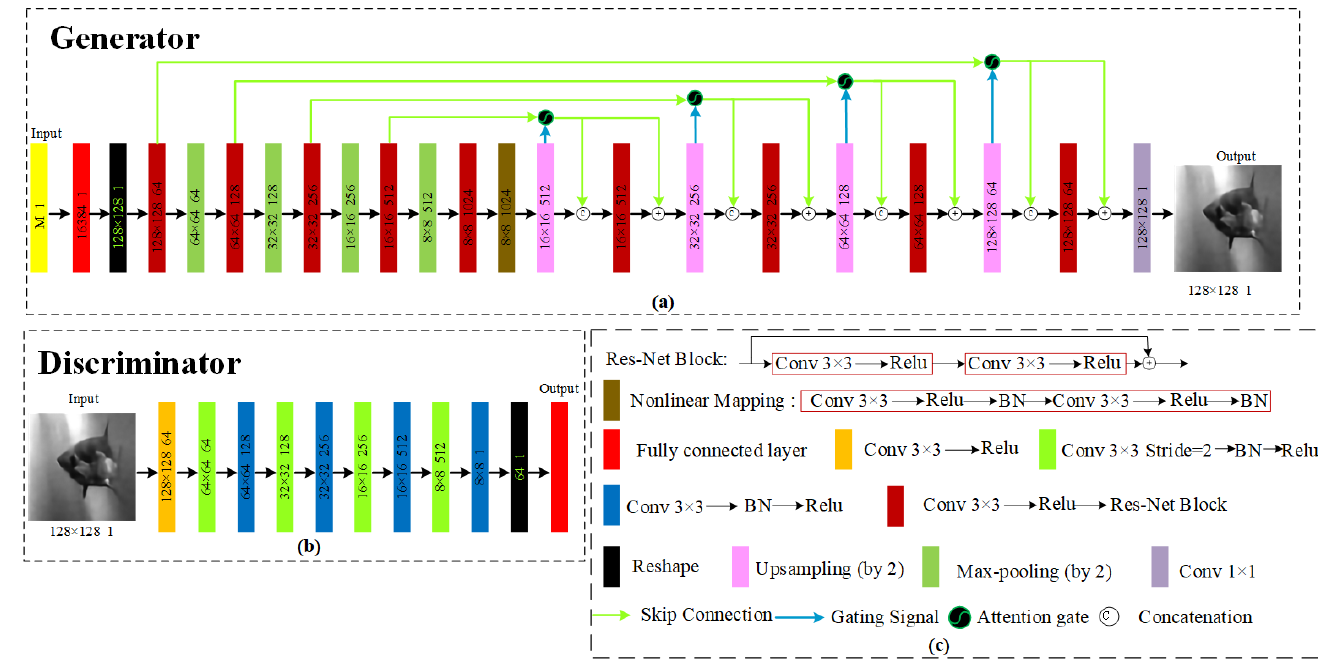
Figure 5. UGI-DL consists of a generator G and a discriminator D. ( a ) architecture of the generator of UGI-DL; ( b ) architecture of the discriminator of UGI-DL; ( c ) annotations of generator and discriminator of UGI-DL.